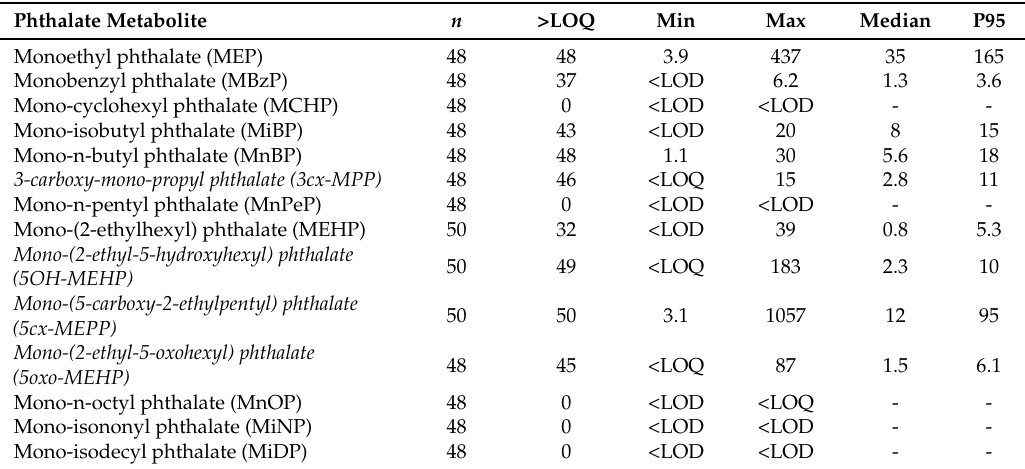
Table 1. Creatinine-adjusted concentrations of phthalate metabolites in urine samples of mothers (in µ g/g creatinine) ( secondary metabolites in italics